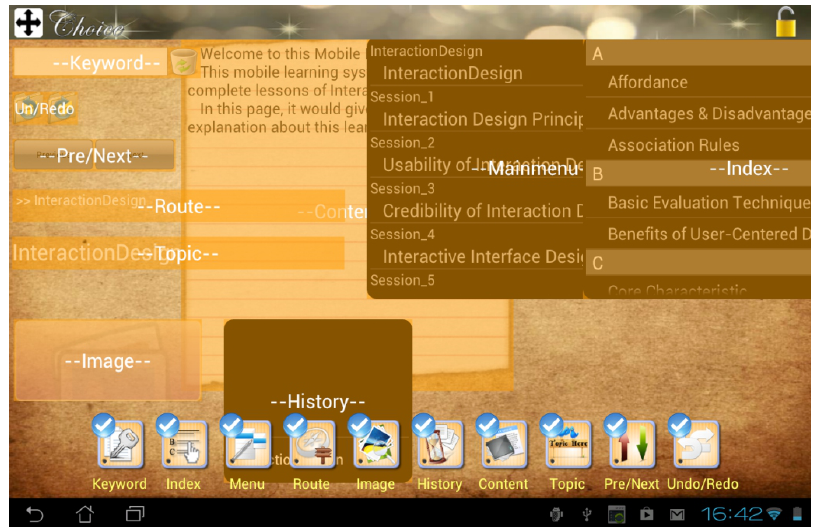
Figure 1. Customized Digital Learning System (Initial